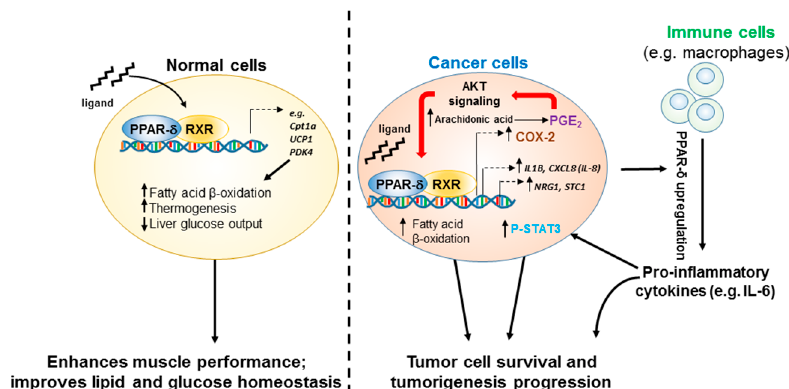
Figure 1. Ligand-dependent actions of PPAR- δ in normal versus cancer cells. Binding of PPAR- δ agonists in normal cells ( left ) leads to the upregulation of genes associated with a switch to using fatty acids as an energy source (increased β -oxidation). It is also associated with systemic improvements in serum glucose regulation through effects on multiple tissues, including pancreas, adipose, liver, and muscle. In cancer cells ( right ), this capacity for PPAR- δ to promote use of fatty acid substrates as an energy source can enhance cell survival and proliferation under harsh metabolic conditions frequently found in tumors. In addition, both COX-2 and PI3K/AKT signaling pathways are often upregulated in tumor cells. Interaction of activated PPAR- δ with these key signaling hubs leads to establishment of a feed-forward circuit promoting cancer development and progression through upregulation of additional factors that enhance neoplastic processes in cancer cells themselves as well as noncancer cells (e.g., tumor-associated macrophages) that make up the tumor microenvironment. See text for additional details.